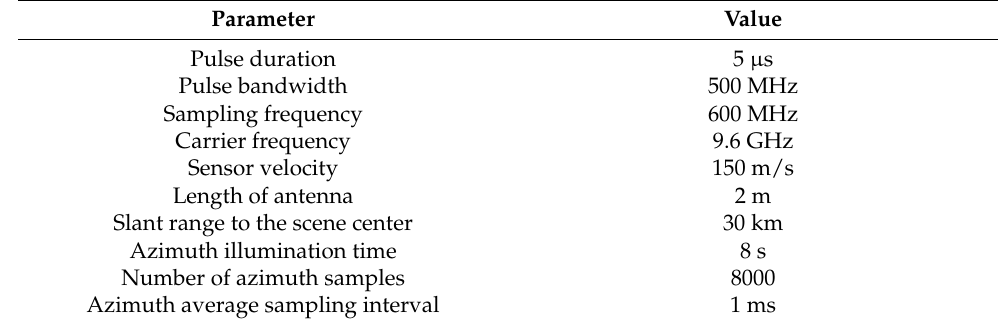
Table 1. Simulation parameters.